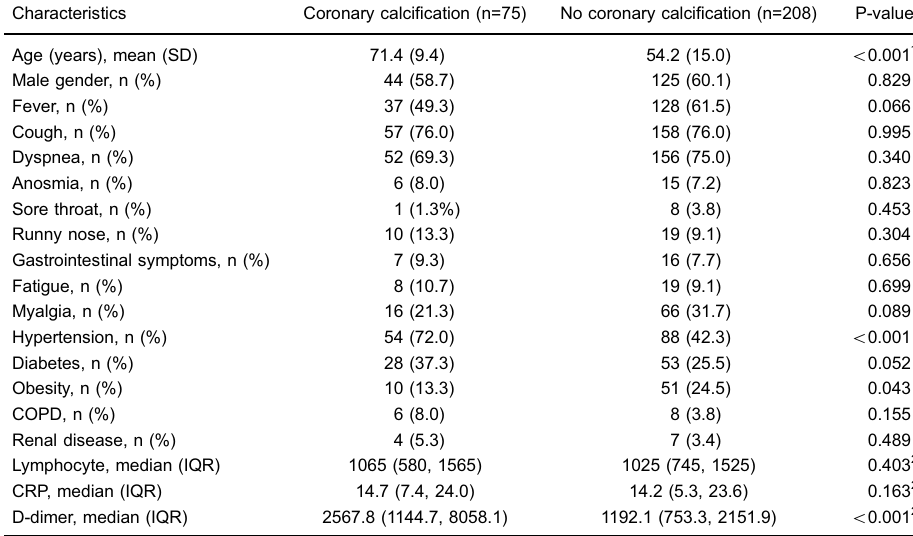
Table 1. Baseline characteristics of the sample with Covid-19.